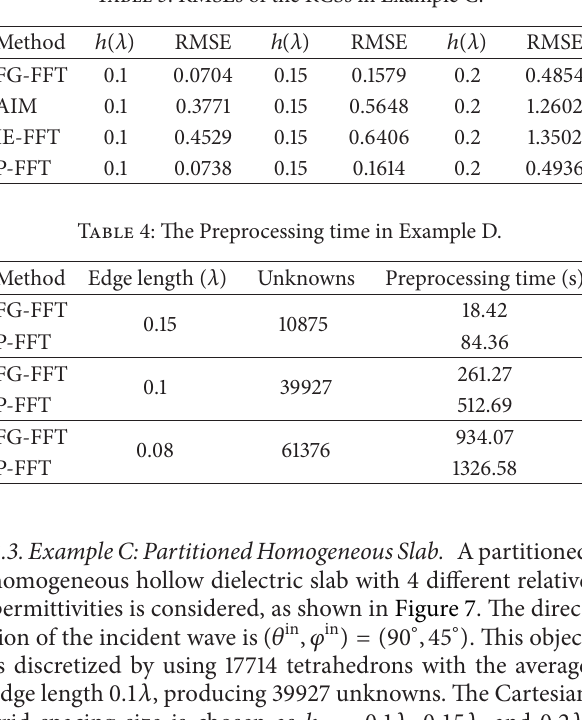
Table 3: RMSEs of the RCSs in Example C.